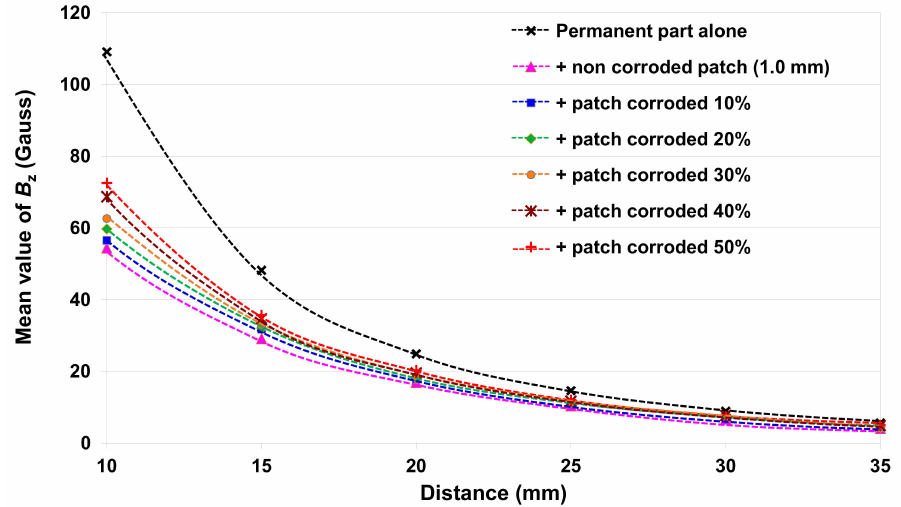
Figure 10. Mean value of B z measured with the Hall gaussmeter as a function of measurement distance for the permanent part, alone and coupled with 1.0 mm-thick patches with different RML, from the 10 mm to 35 mm